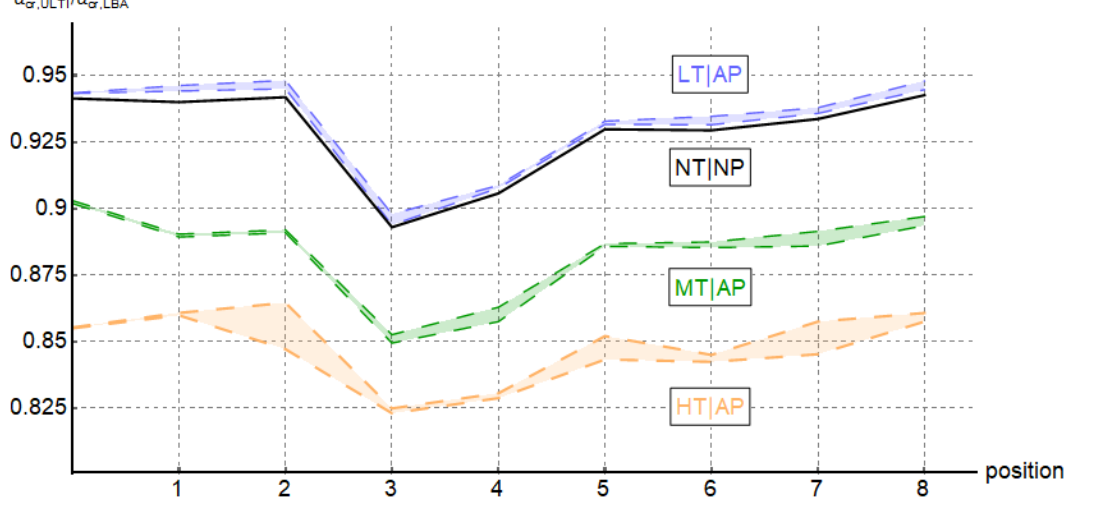
Figure 16: Resultant ranges of critical load factor ratios. NT – no tension, LT – low tension (1 kN), MT – middle tension (500 kN), HT – high tension (1000 kN), NP – no prestress, AP – all prestress cases (10, 15, 20